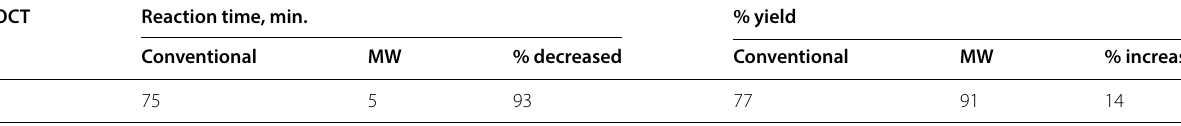
Table 1 Reaction time and % yield of OCT under conventional reflux and microwave irradiation, respectively OCT Reaction time,